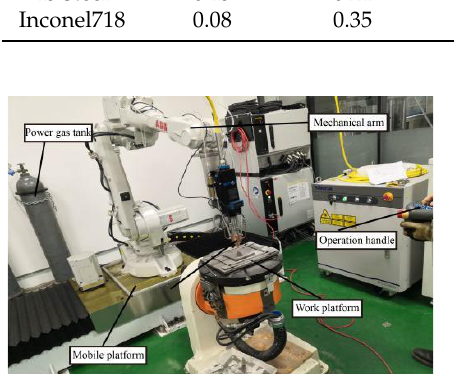
Figure 9. The 3 kW fiber laser cladding machine.